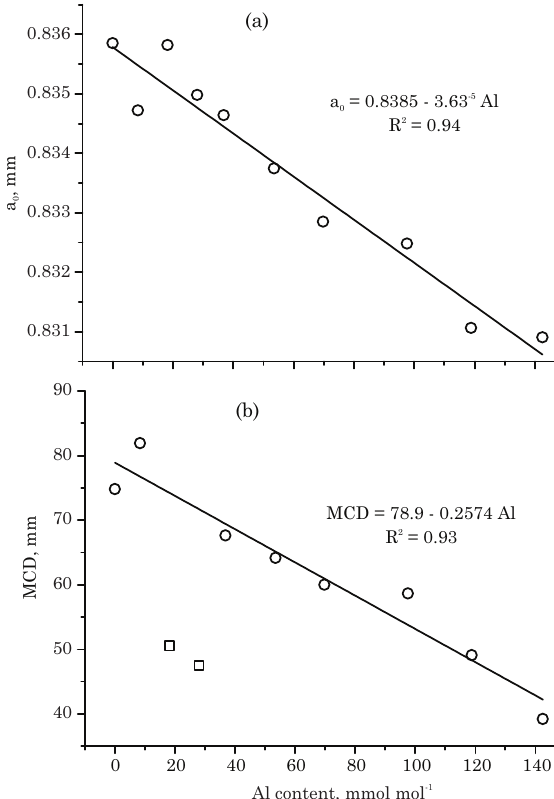
Figure 2. Average lattice parameter ( a 0 ) for the Al- substituted maghemite (a), and mean crystalline diameter for the Al-substituted maghemites (b), as a function of aluminum content.( o )